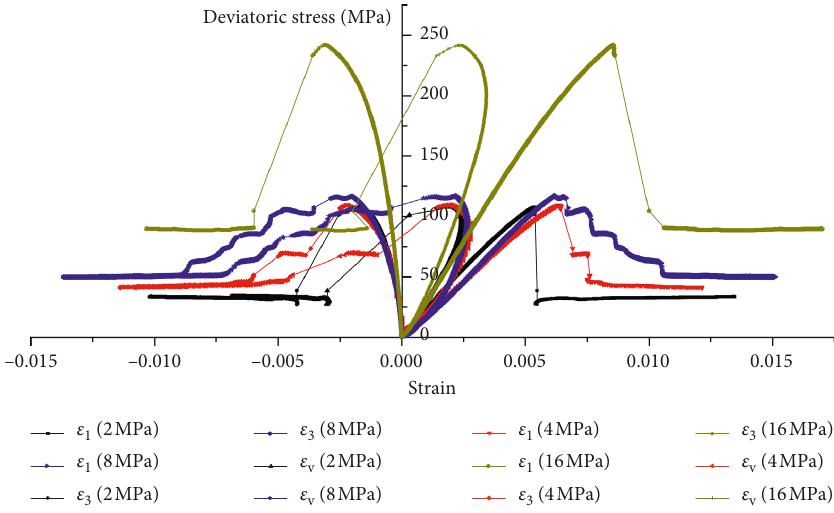
Figure 5: The curves of b2 rocks for triaxial loading tests. Table 1: The mechanical parameters of b2 rocks under loading